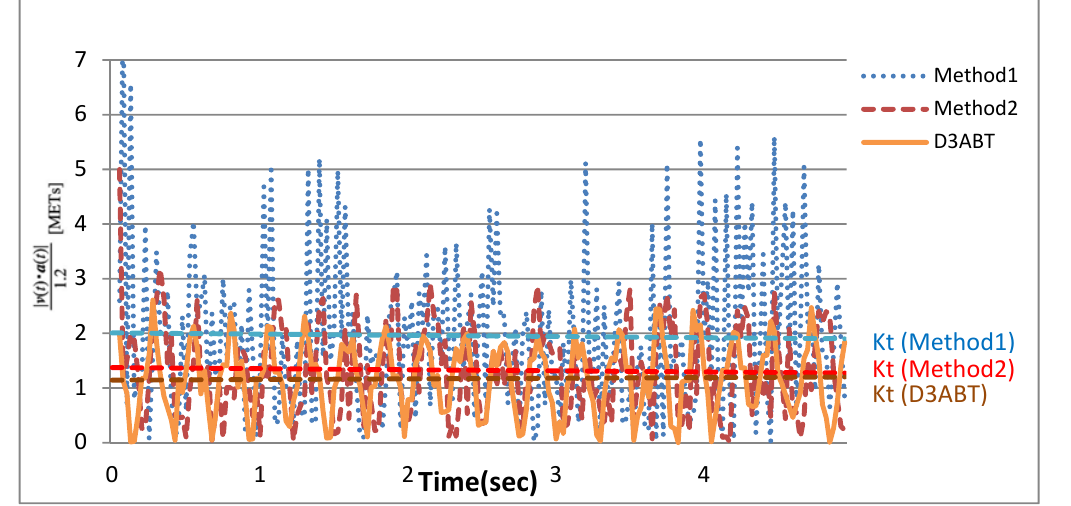
Figure 14. The comparison of work done by inertia K